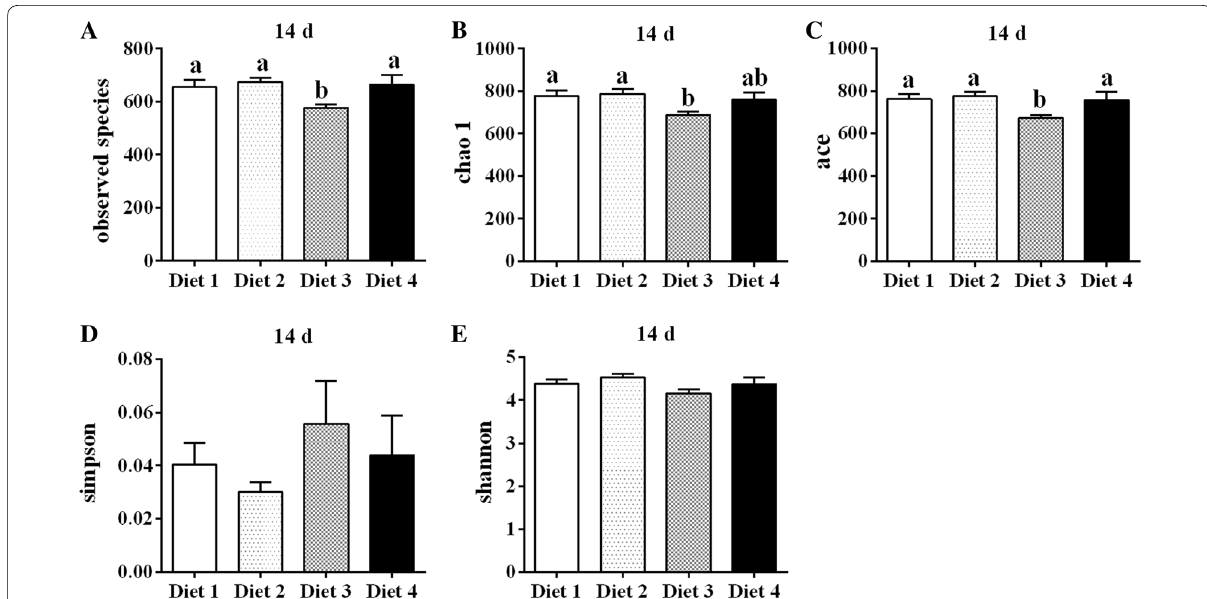
Fig. 2 Alpha diversity indices of fecal bacterial communities of weaned piglets on day 14 in different groups. A – E Observed species, chao 1, ace, simpson, and shannon, respectively. a,b Small letter superscript represents significant difference ( P < 0.05). Data were statistically analyzed by one-way ANOVA, followed by Duncan’s multiple-range test